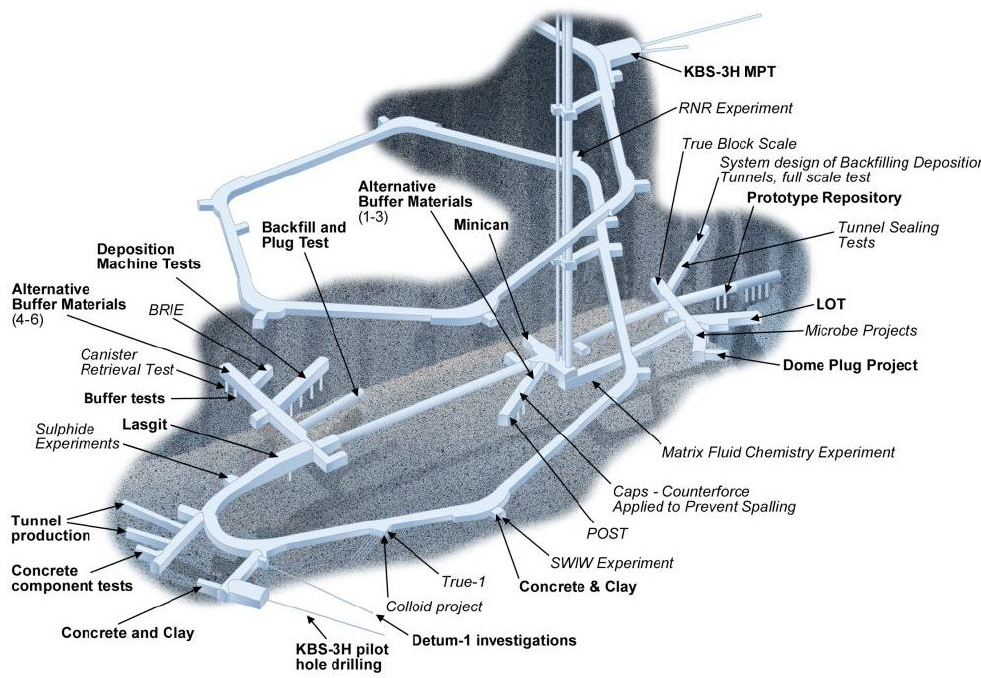
Figure 3. Allocation of experiments at Äspö HRL [57]. Reprint with permission of Äspö HRL, 2021, https://www.skbinternational.se.